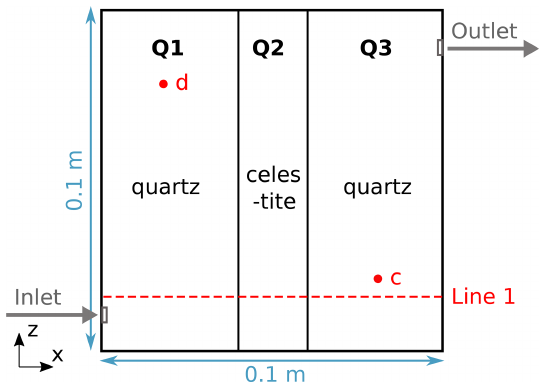
Figure 1. Poonoosamy et al. (2021) benchmark model geometry with location of observation points (c) and (d) as well as Line 1. The initial solution is injected at the inlet, flowing through regions of three different mineralogies (Q1, Q2 and Q3), with the resulting solution leaving the flow cell via the outlet.